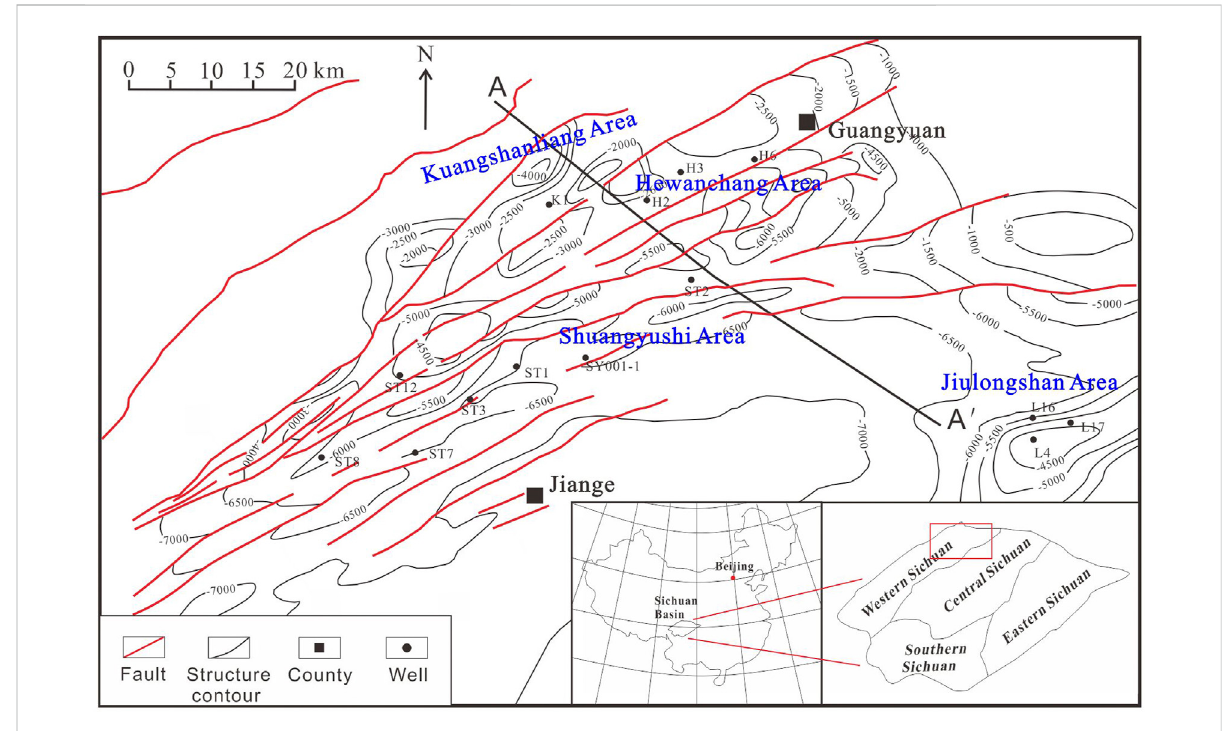
FIGURE 1 Regional position of the Northwestern Sichuan Basin. Note the top structure contours of the Qixia